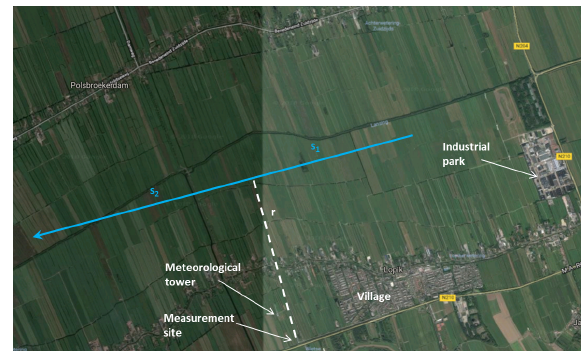
Figure 12. Map of the area around the measurement site. The trans- port event’s trajectory on 20 September 2016 is indicated by a blue arrow (source: © Google